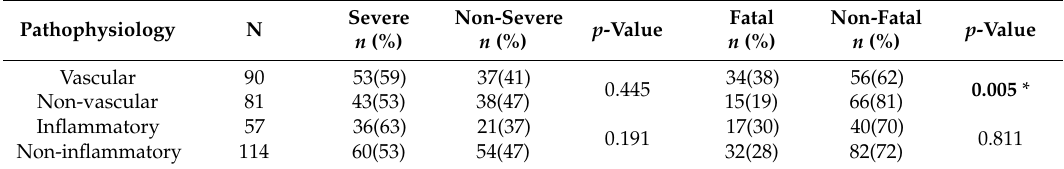
Table 4. Severity and outcome status of COVID-19 by type of neurological pathophysiology ( n = 171). Pathophysiology